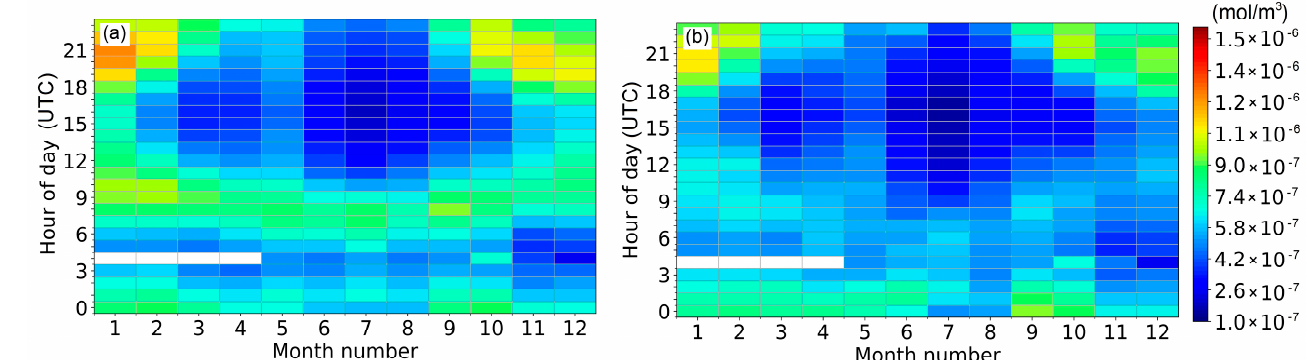
Figure 7. Hourly and monthly variation of in situ NO 2 for ( a ) weekdays and ( b ) weekends over the period 2017–2022.